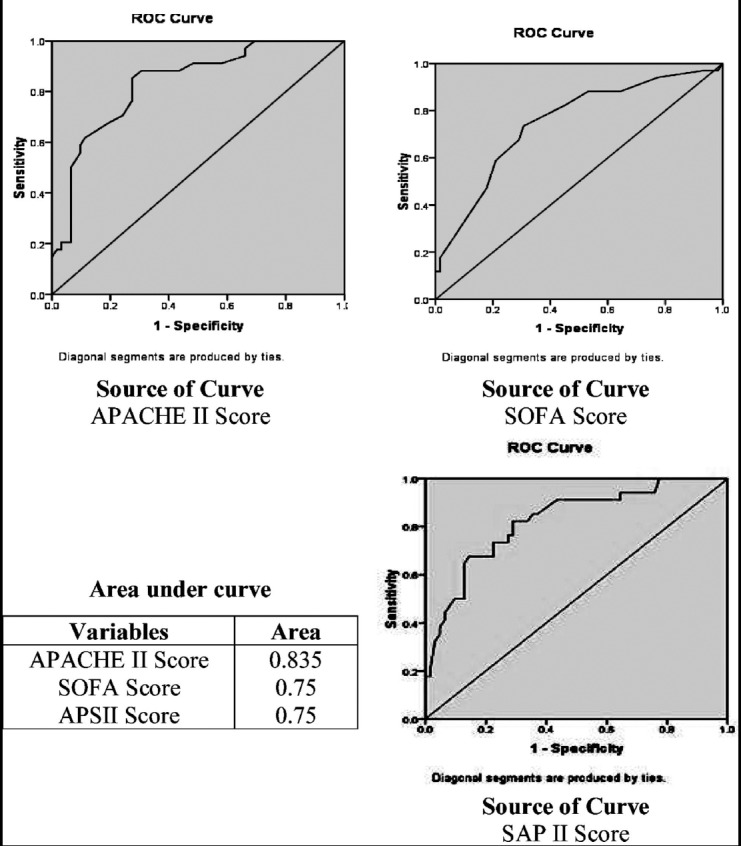
ROC curves of APACHE II, SOFA and SAPII on prediction of mortality.